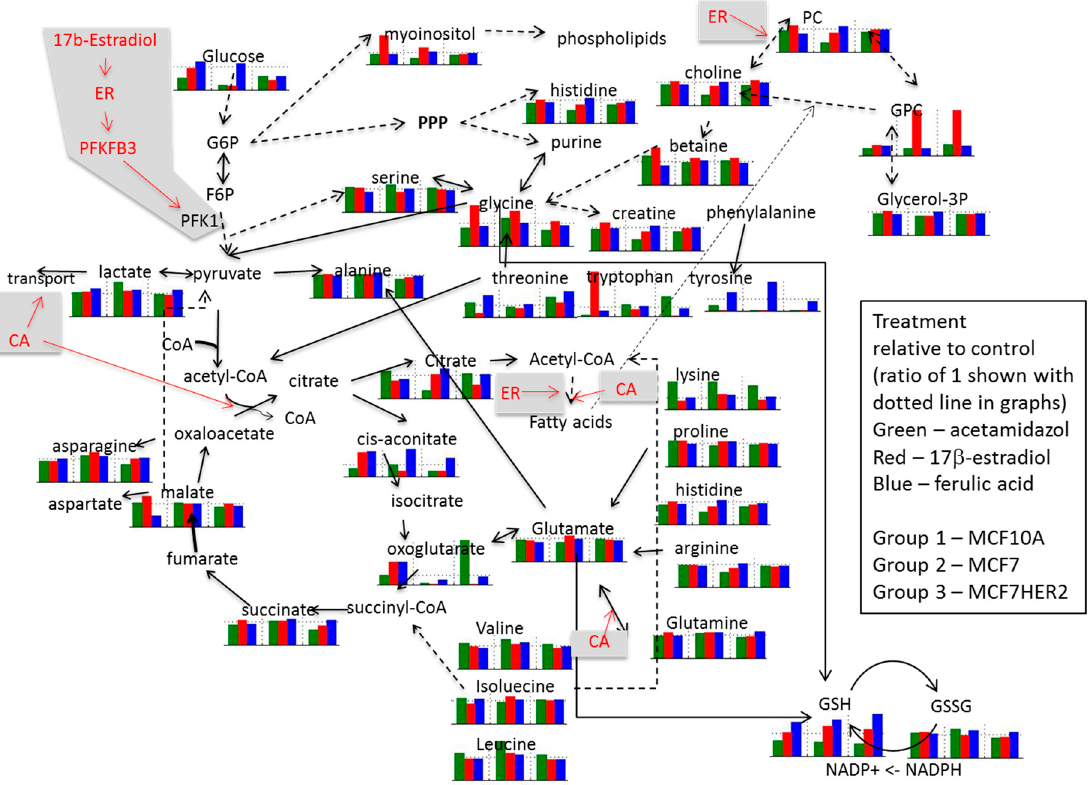
Figure 7. Schematic presentation of proposed effects of ER agonists and CA inhibition on metabolism. Imbedded graphs show metabolite concentration changes following acetazolamide, 17 β -estradiol and ferulic acid treatment in MCF10A, MCF7 and MCF7HER2 relative to untreated controls in the same cell lines. Horizontal dotted line in each graph shows a value of 1 (relative effect value in untreated cells). Dashed arrowed lines show indirect (through several steps in the pathway) connection between metabolites; solid arrowed lines show direct pathway connection between metabolites. Values are from 3 to 5 independent experiments.